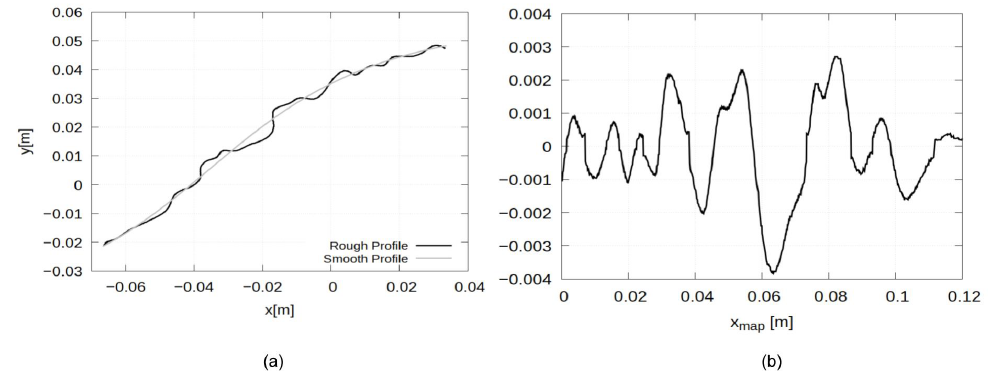
Figure 3. An example of: ( a ) smoothing a rough surface using cubic spline and ( b ) mapping roughness to x